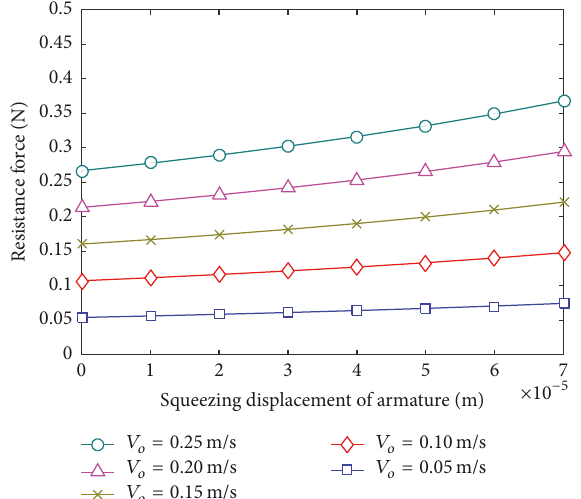
Figure 5: Resistance forces acting on the armature at different velocities.